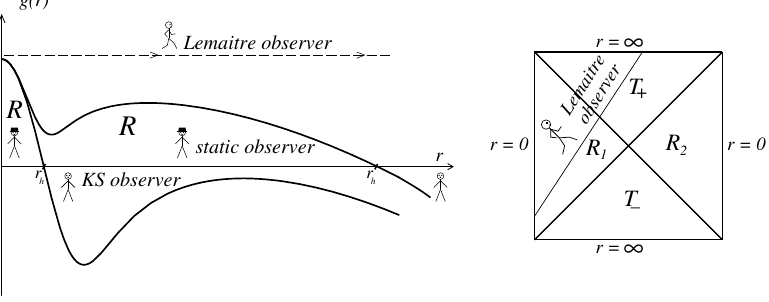
Figure 2. One-horizon spacetimes with vacuum dark